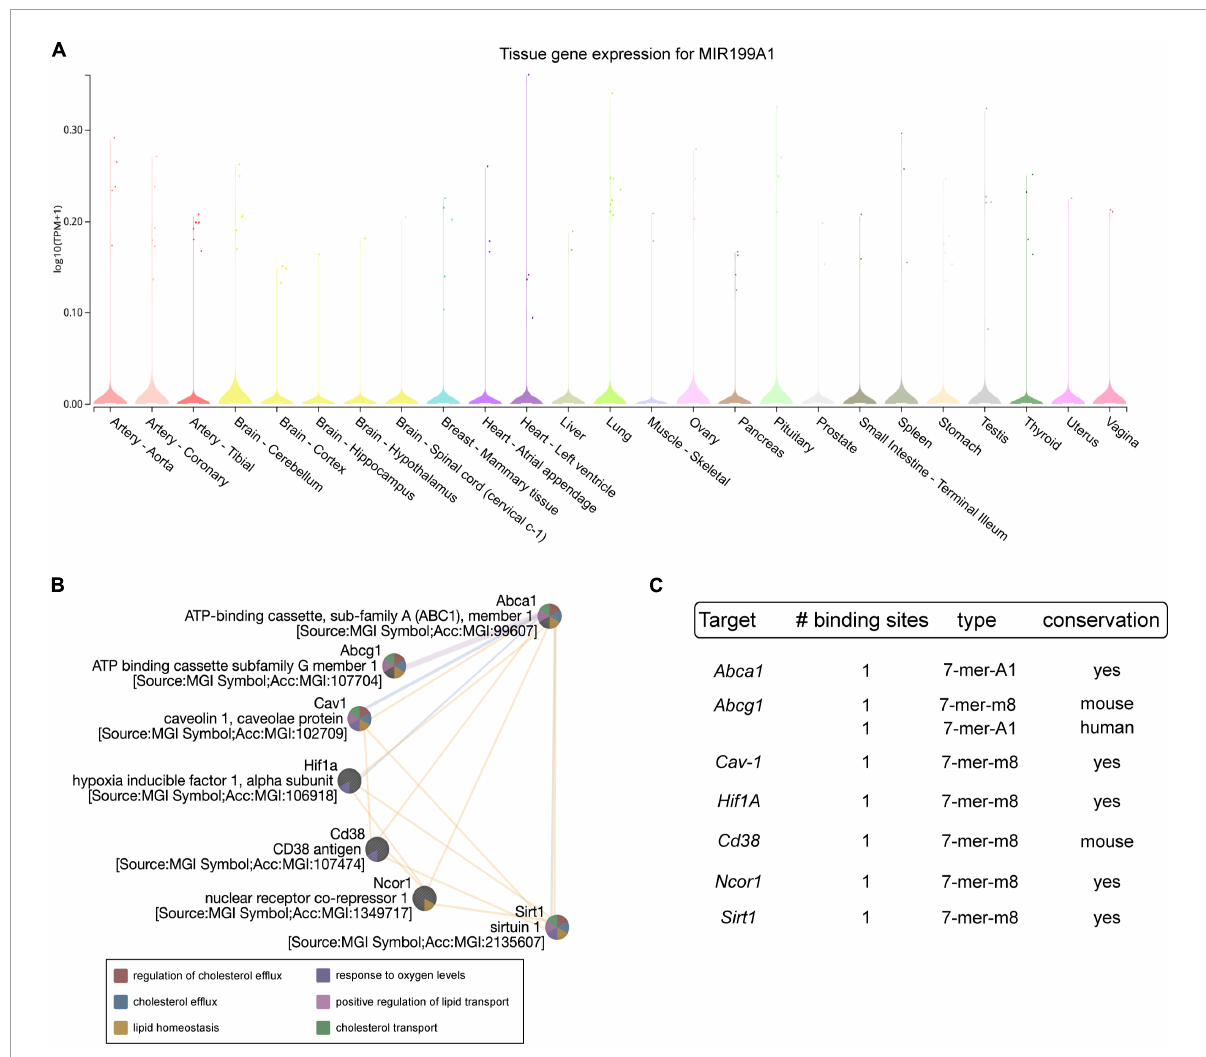
FIGURE1 Analysis of miR-199a-5p targets involved in Atherosclerosis. (A) Representation of miR-199a-5p expression in human tissue using Gtex Portal. Expression values are shown in TPM (Transcripts Per Million), calculated from a gene model with isoforms collapsed to a single gene. No other normalization steps have been applied. Box plots are shown as median and 25th and 75th percentiles and points are displayed as outliers if they are above or below 1.5 times the interquartile range. (B) Bioinformatic analysis of prominent miR-199a-5p target genes obtained thought TargetScan 6.2. involved in atherosclerosis using GeneMania. Blue lines indicate pathway co-localization, yellow lines indicate predicted and purple lines indicate co-expression. (C) Table of human predicted targets genes of miR-199a-5p involved in atherosclerosis obtained using TargetScan 6.2., showing the number and type of the putative binding sites and the conservation in mouse and